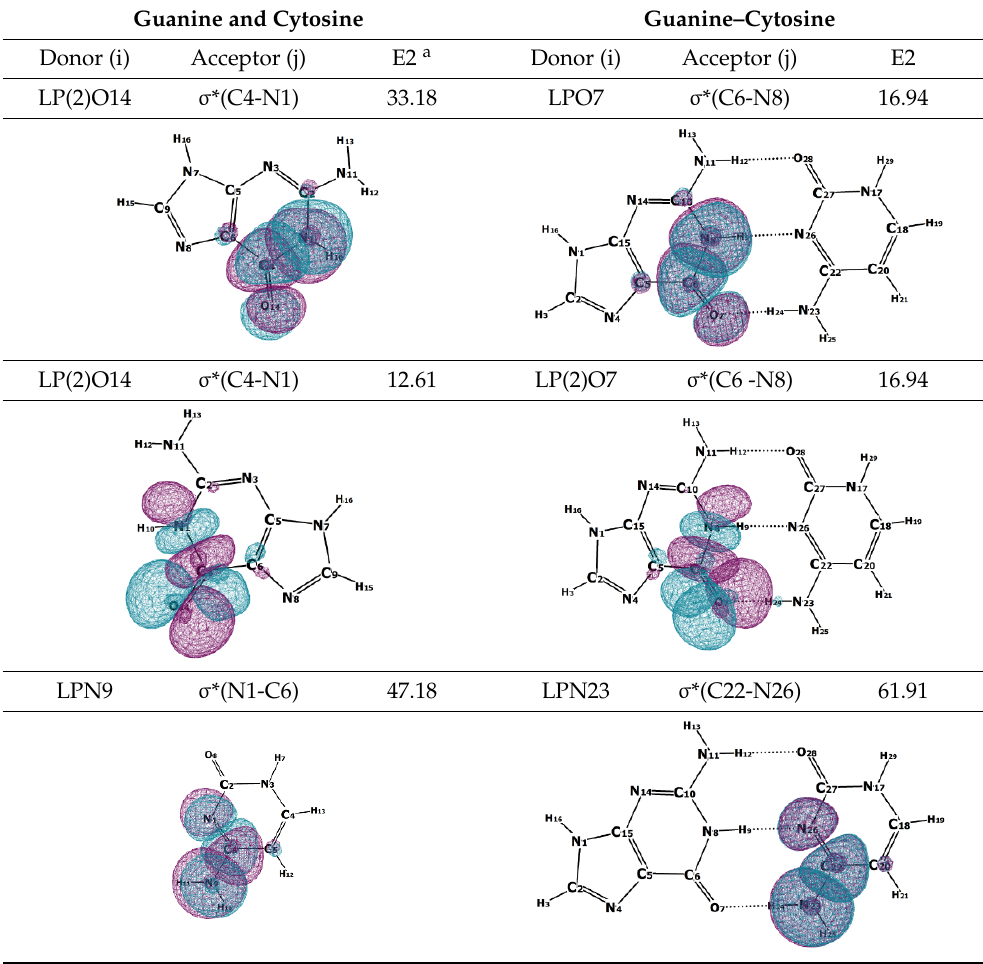
Table 2. Second-order perturbation theory analysis in NBO basis for non-bonded interactions in guanine and cytosine molecules at the B3LYP/6-31G* level of theory.